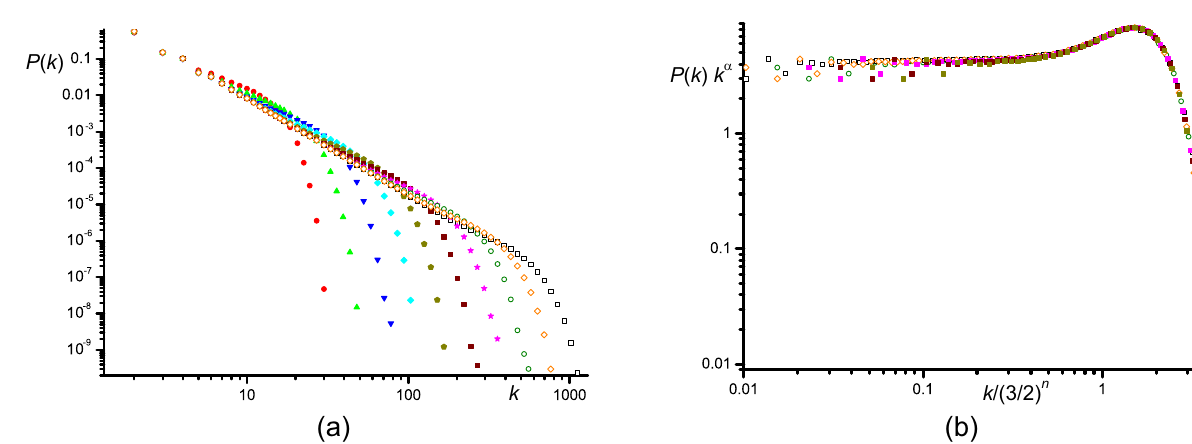
Figure 3. ( a ) Degree distributions of the tetragon-based networks of generations 5–14 as indicated. The results shown are obtained after averaging over 2 × 10 5 realizations and logarithmic binning with step 1.1. ( b ) Same distributions but rescaled as the axes